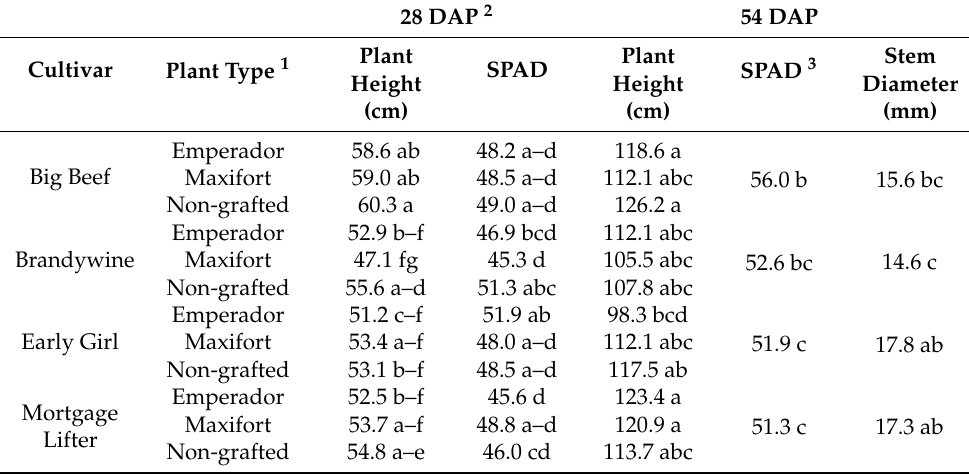
Table 1. Plant vegetative growth of six tomato cultivars when grafted onto two types of rootstocks or grown non-grafted in a high tunnel during the 2020 growing